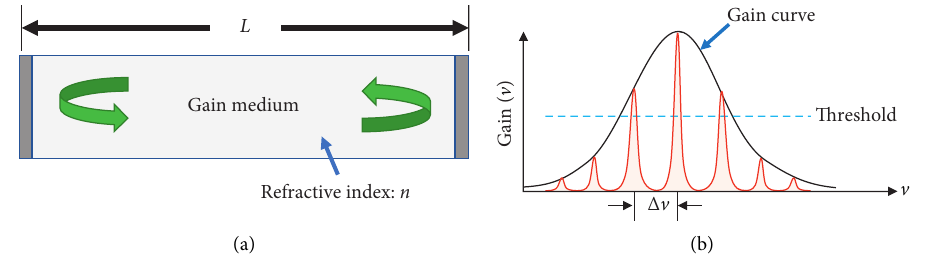
Figure 1: Schematic of (a) oscillator structure and (b) oscillation spectrum.